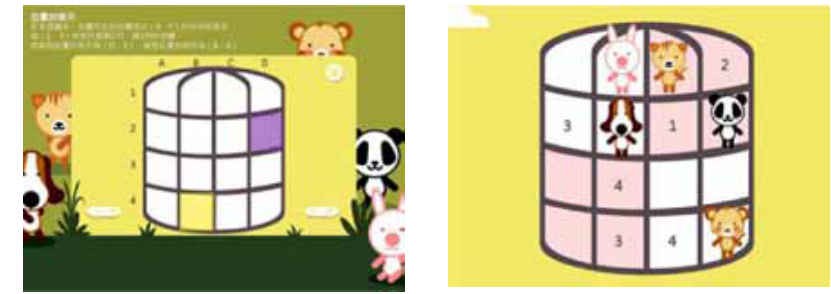
(a) Explanation on grid coordinates (b) Cute animals corresponding to path choices